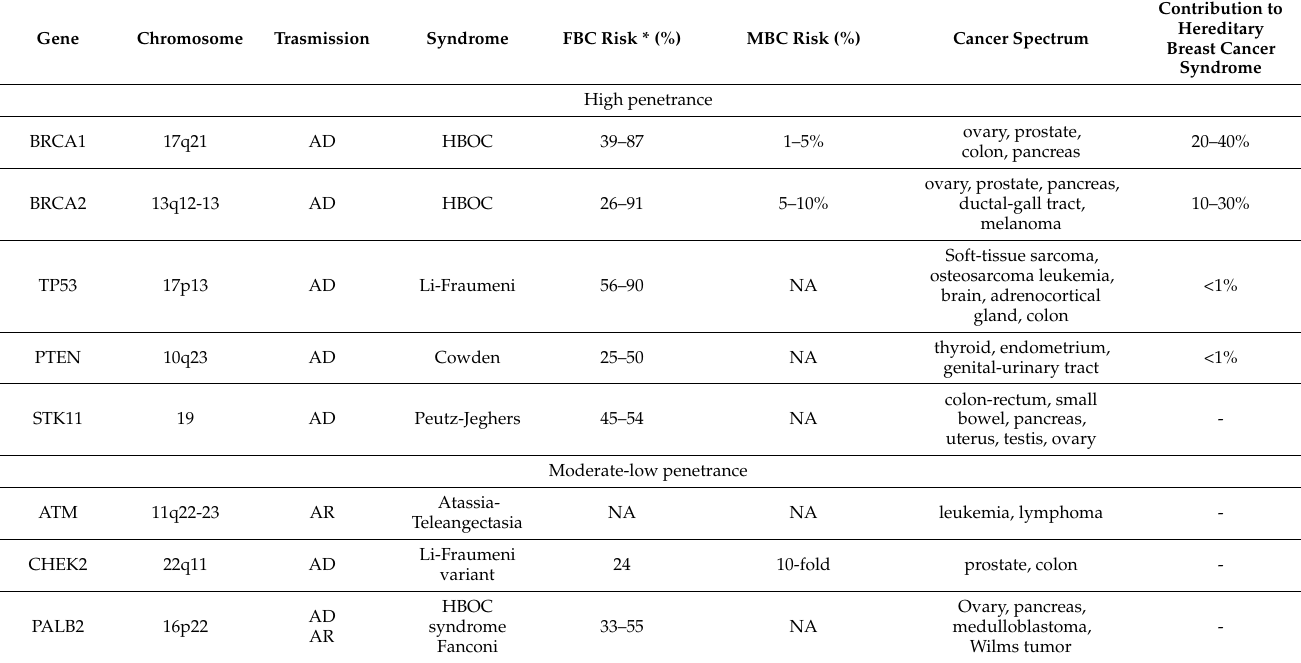
Table 1. Male breast cancer (MBC) risk associated with BRCA1/2 and other moderate-/low- penetrance